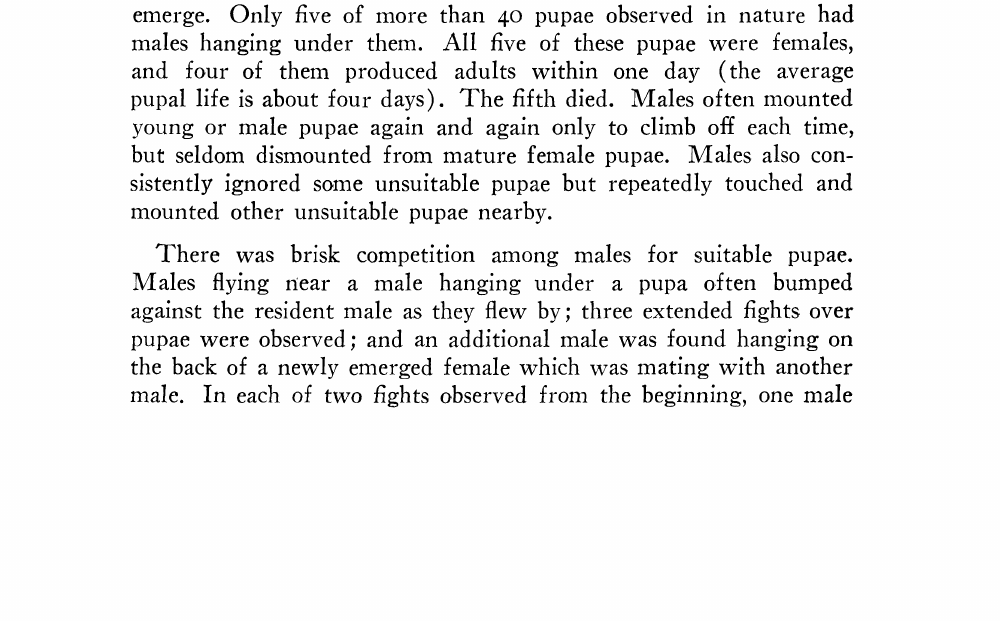
Fig. 1. A male L. subcaeruleus clinging to a